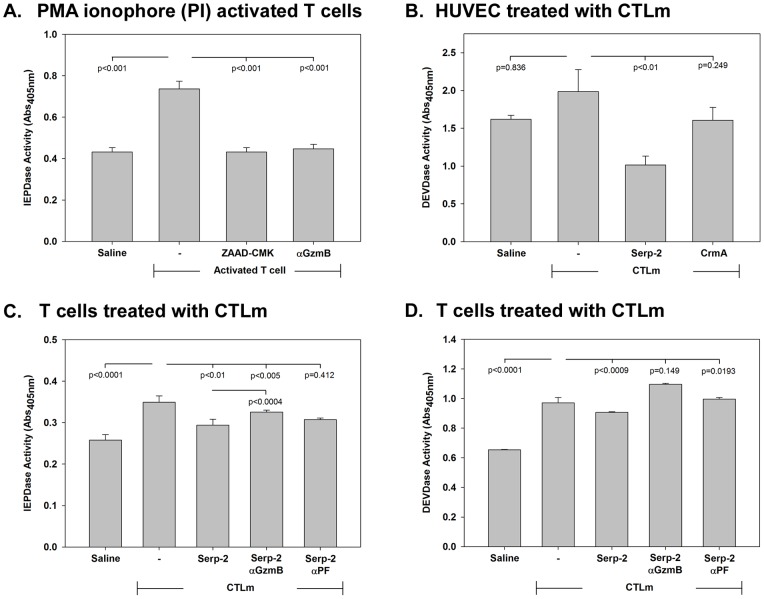
Blockade of granzyme B reduces viral cross-class serpin inhibition of T cell induced T cell apoptosis.Jurkat T cells were treated with PMA and ionophore (PI) and the level of granzyme B expressed was measured by IEPDase assay and caspase 3 and 7 activity by DEVDase assay (A). Increased granzyme B (GzmB, p<0.001) secreted by these cells and was inhibited by treating the cells with an intracellular inhibitor of granzyme B, ZAAD-CMK (p<0.001) or anti-granzyme B antibody (p<0.001) (A). The medium containing granzyme B from PI treated T cells (CTLm) was applied to naive HUVECs to induce apoptosis (B). Treatment with Serp-2, but not CrmA, reduced caspase activity in CTLm treated HUVECs (B). The CTLm was also applied to naive T cells in culture to induce apoptosis and increased levels of caspase 3 and granzyme B were observed as IEPDase activity (C, p<0.0001) and DEVDase activity (D, p<0.0001) respectively. Treatment with Serp-2 reduced both granzyme B (C, p<0.01) and caspase 3 (D, p<0.0009) activities significantly. Antibody to granzyme B (GzmB) blocked Serp-2 mediated reductions in CTLm induced granzyme B (C) when compared to Serp-2 treatment alone (p<0.0004), but with a still significant decrease (p<0.005) when compared to CTLm treatment alone. Antibody to granzyme B also blocked the Serp-2 mediated decrease in caspase 3 (D, p<0.149) when compared to CTLm activation. This Serp-2 mediated inhibition of CTLm induced granzyme B activity was also blocked by incubation of cells with antibody to perforin (C, p = 0.412) but not the caspase 3 activity (D, p<0.0193). The results shown here represent mean ± SE from 3 to 5 replicates for each experiment. Significance was assessed by analysis of variance (ANOVA) with secondary Fishers least significant difference and Mann Whitney analysis.